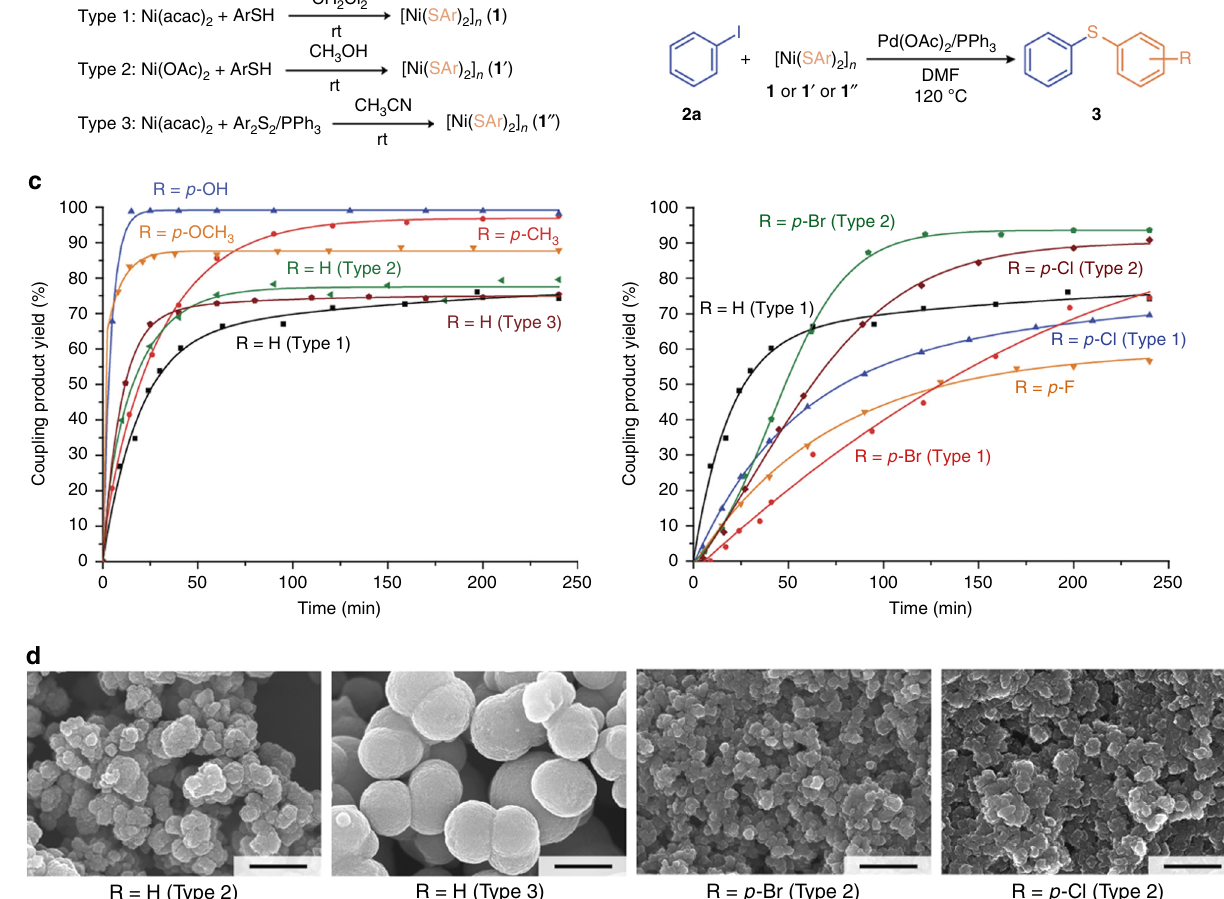
Fig. 8 Kinetic measurements for C – S cross-coupling reactions with nickel thiolates. Synthesis of different types of thiolates ( a ); C – S cross-coupling reaction conditions ( b ); obtained kinetic curves ( c , thiolate of Type 1, was used unless speci fi ed otherwise); FE-SEM images of nickel thiolates of types 2 and 3 ( d ). Scale bars – 500 nm for all